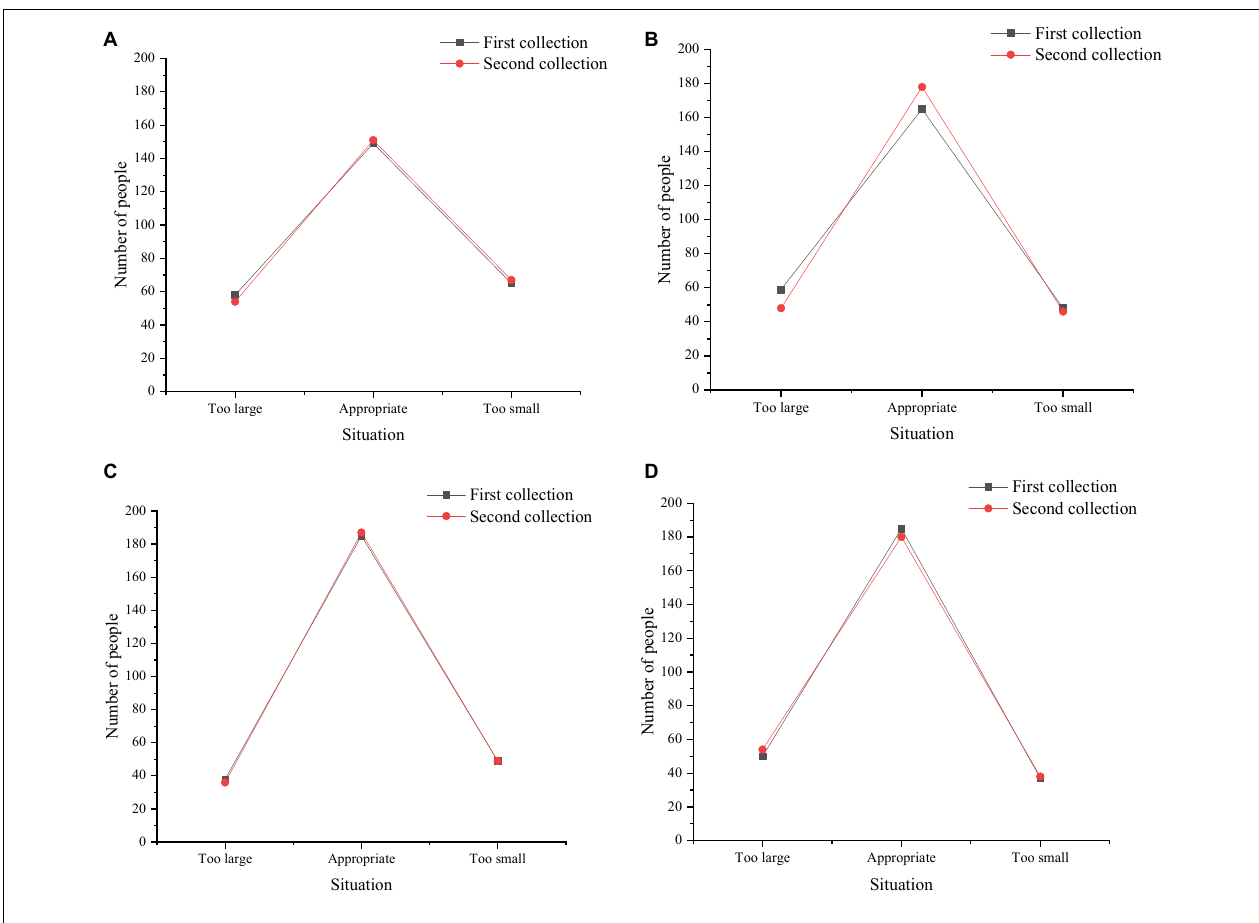
FIGURE 6 | The difficulty of film clips in film teaching ( A , 2 h; B , 4 h; C , 6 h; D , 8 h).